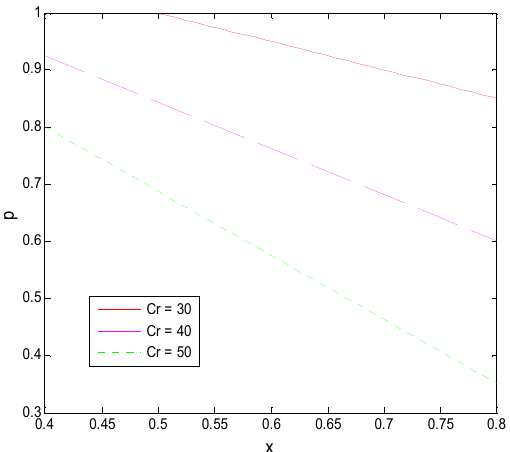
Figure 13. The effect of the transformation success rate on a faculty inventor’s willingness to “comply with the rules”.